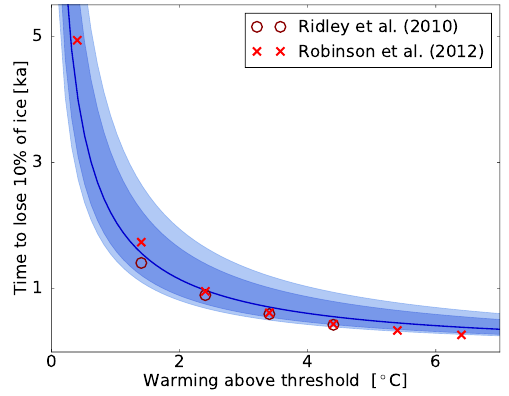
Figure 2. Decay time of the Greenland Ice Sheet. The decay time depends critically on the level of warming above the temperature threshold. Shown are the median (black line), likely (18–83% quan- tiles, dark blue shading) and very likely (5–95% quantiles, light blue shading) ranges for the time to melt 10% of the present-day ice volume, estimated via Eq. (17). The red circles and crosses in- dicate the results from process-based model simulations by Ridley et al. (2010) and Robinson et al. (2012) respectively.